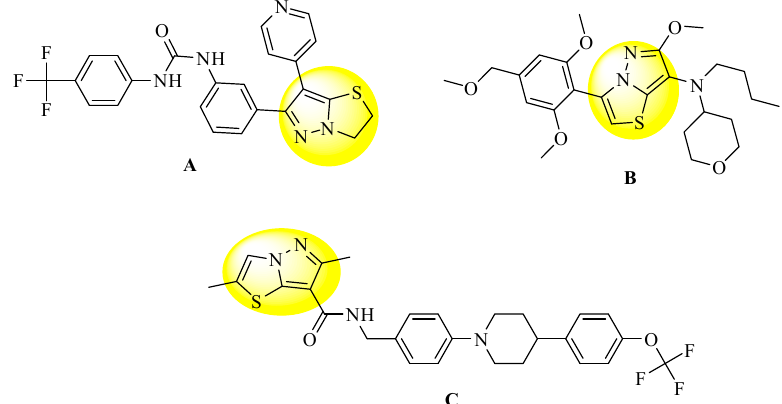
Figure 3. Pharmacologically active pyrazolo[5,1- b ]thiazole